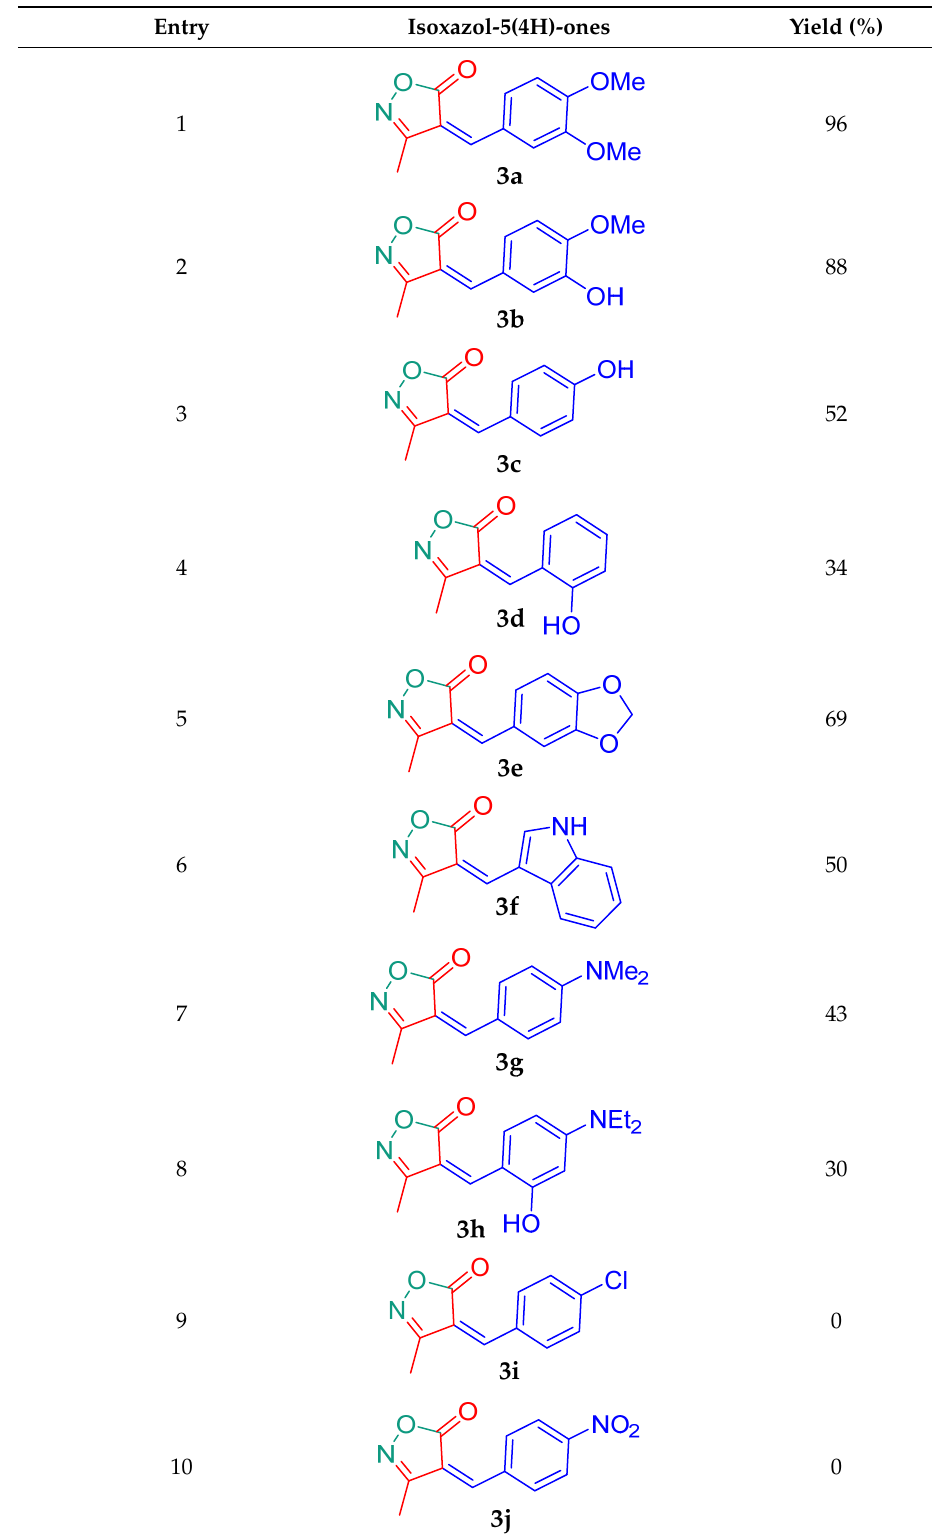
Table 3. Scope for the MCR flow photochemistry synthesis.